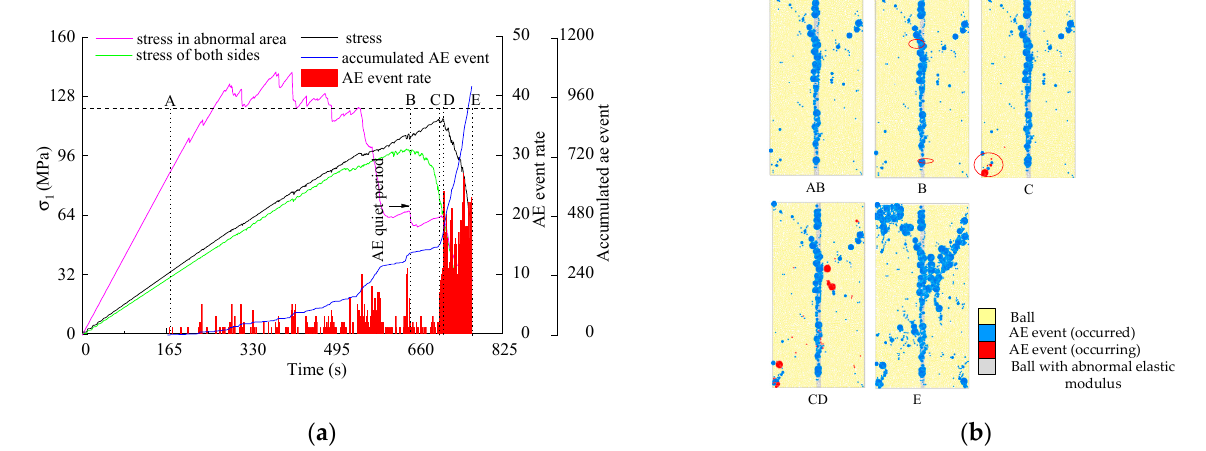
Figure 6. Numerical simulation results. ( a ) Stress and AE events of specimens with abnormal elastic modulus of 60 GPa; ( b ) AE events distribution at different stages of the specimen.